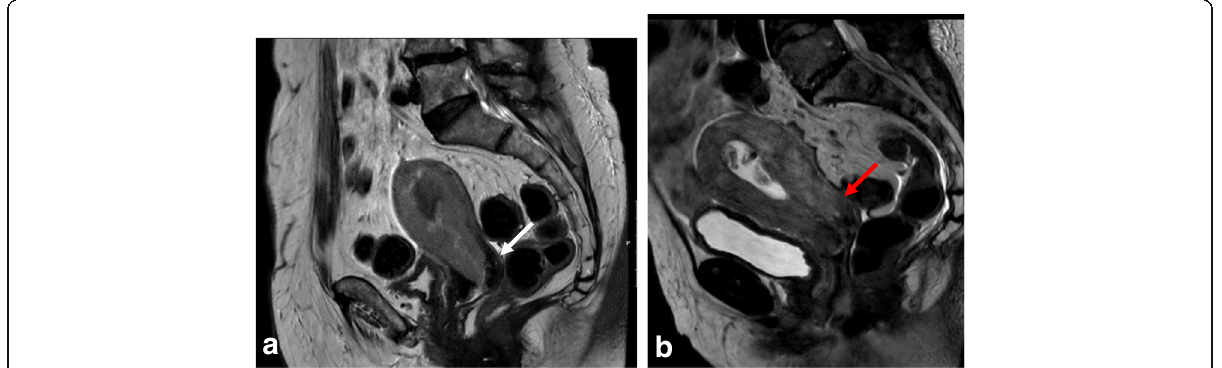
Fig. 7 Endometrial cancers visualized by sagittal T2WI. a No cervical invasion; cervical stromal is preserved (white arrow). b Direct cervical invasion; cervical stroma is invaded (red